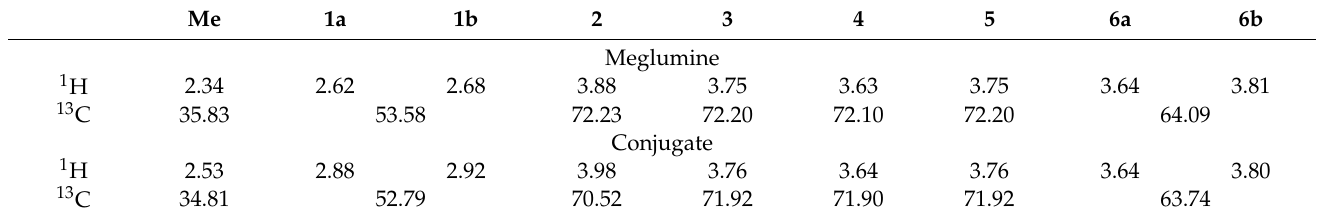
Table 2. Chemical shifts of the 1 H and 13 C atoms in the NMR spectra of free meglumine and the meglumine residue in the polymer-based conjugate.